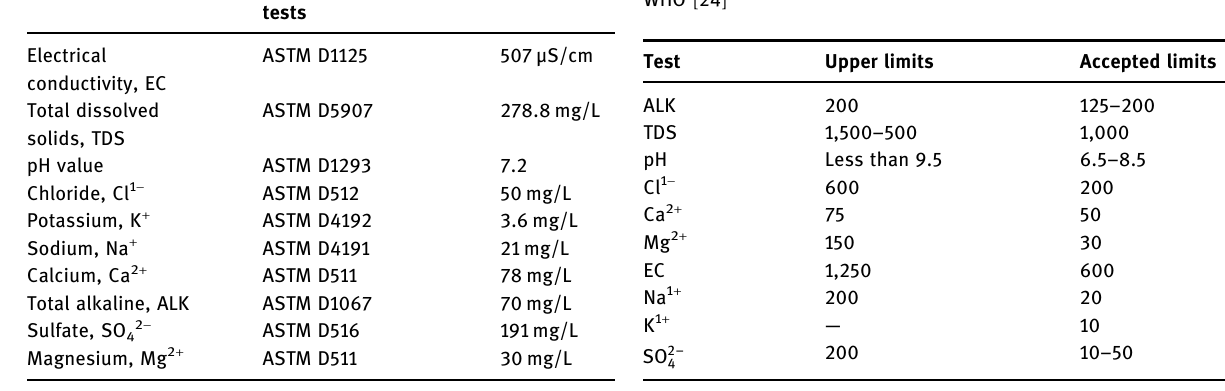
Table 2: Standard speci fi cations for water type according